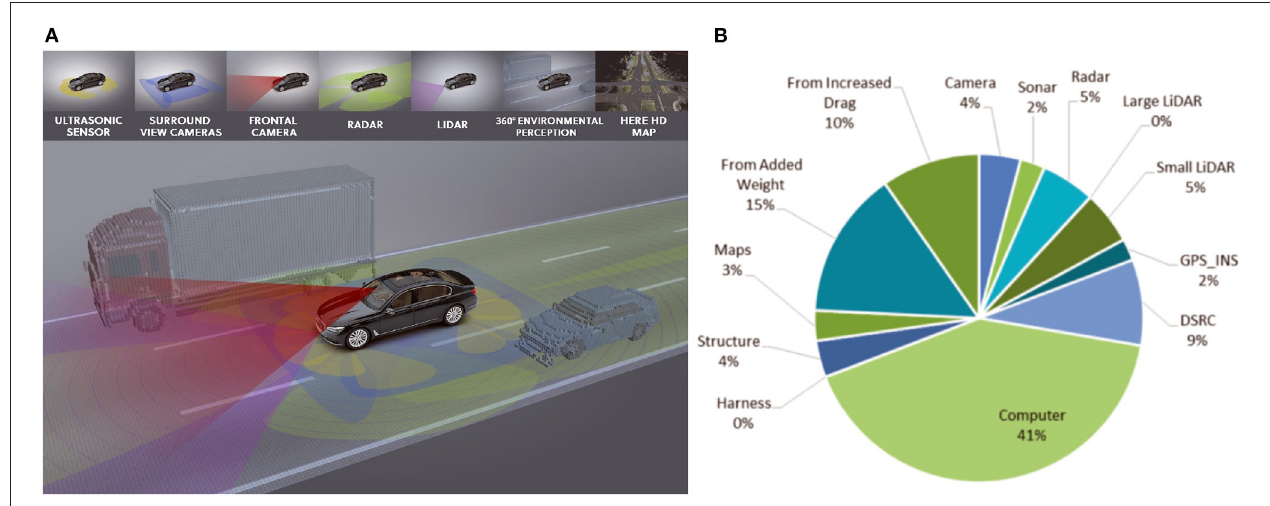
FIGURE 1 | (A) Exemplary sensor setup of an automated vehicle prototype. Image source: BMW. (B) Sources of added energy consumption on a medium automated vehicle system on an electric vehicle prototype. Reprinted with permission from Gawron et al. (2018) Copyright 2018 American Chemical